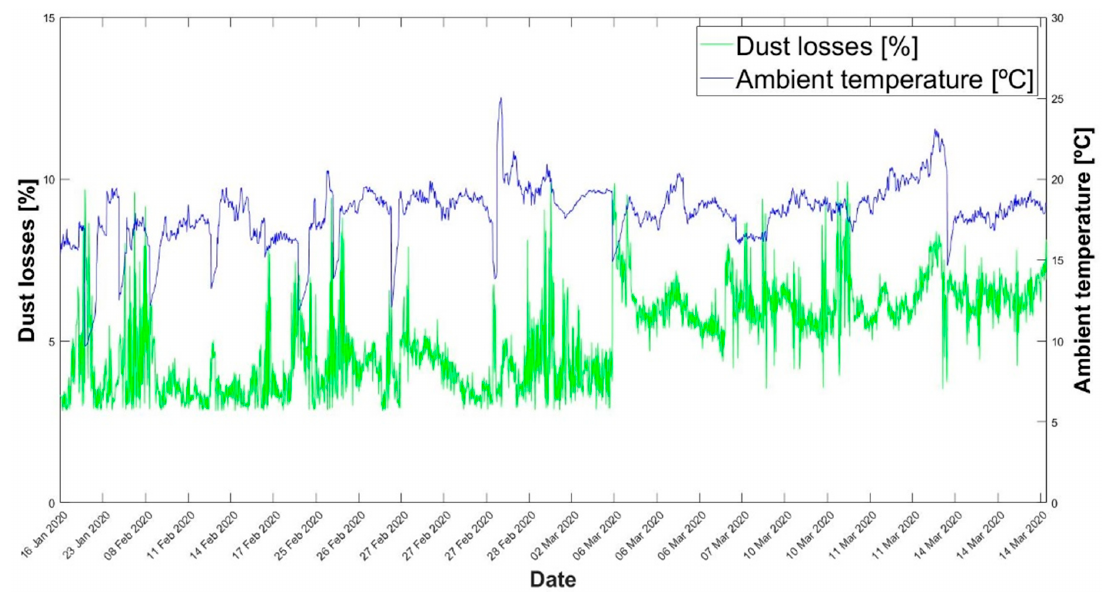
Figure 9. Variation in the production loss associated with dust and the ambient temperature in the experimental plant during the measurement campaign.